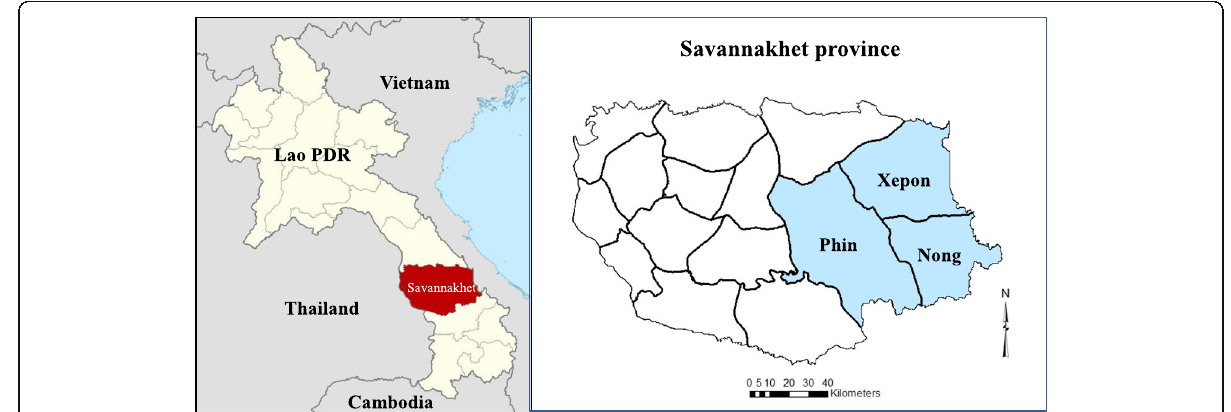
Fig. 1 Study districts: Xepon, Phin, and Nong Districts, Savannakhet province, Lao